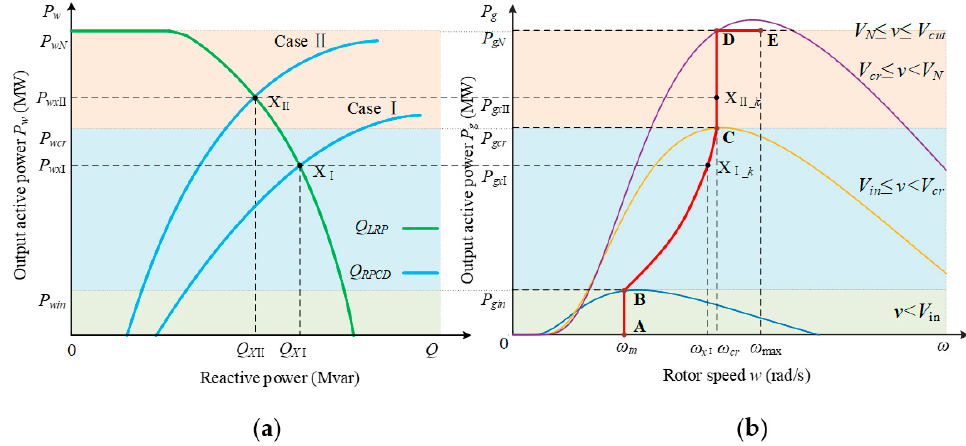
Figure 3. The power characteristics of energy generation from the DFIG-based wind farm. ( a ) The interaction between the LPR and the RPCD. ( b ) The active power characteristics of DFIG.